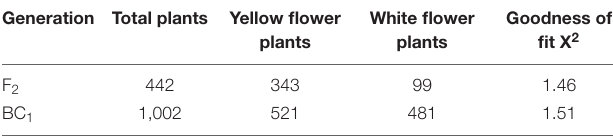
TABLE 1 | The segregation of flower colors in the F 2 and BC 1